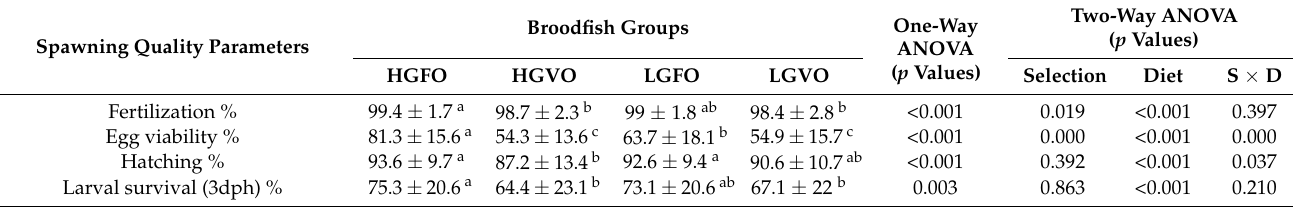
Table 12. Relative spawning quality (%) in gilthead seabream broodstock selected for high (HG) or low (LG) growth fed with either FO or VO diet over three months of reproductive season (HGFO, n = 70; HGVO, n = 67; LGFO, n = 72; LGVO, n =